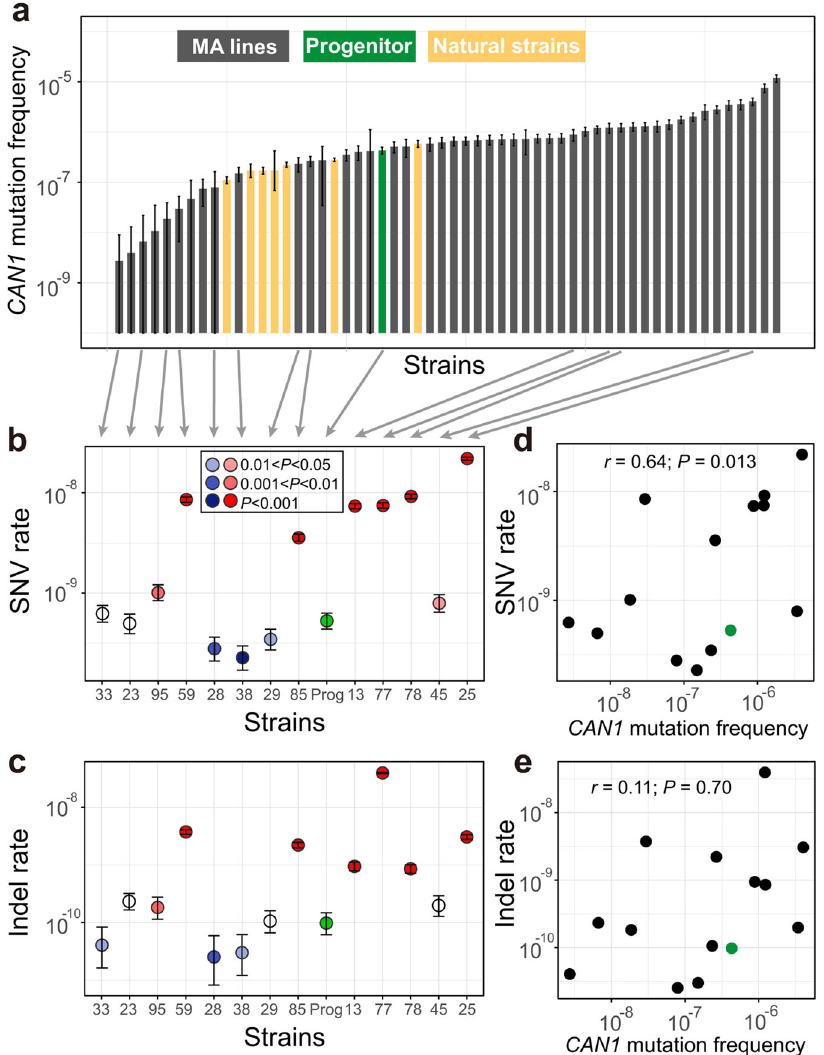
“ Fig. 2 Mutation frequencies and rates of the MA lines. a CAN1 mutation frequencies of the progenitor (green), 48 MA lines (gray), and 7 natural yeast strains (yellow), determined by the fl uctuation test based on 72 (green and gray) or 288 (yellow) biologically independent cell cultures from each strain. The data from the seven natural strains came from ref. 14 . Error bars indicate 95% con fi dence intervals of the mean. Mutation frequency is the probability of loss-of-function mutation in CAN1 per cell division, so is not directly comparable with the mutation rates estimated by MA+ WGS. SNV ( b ) or indel ( c ) mutation rate per site per generation in the progenitor (green) and 13 MA lines estimated by MA+ WGS based on 18 to 20 biologically inde- pendent replicates. Numbers on the X-axis refer to IDs of MA lines,